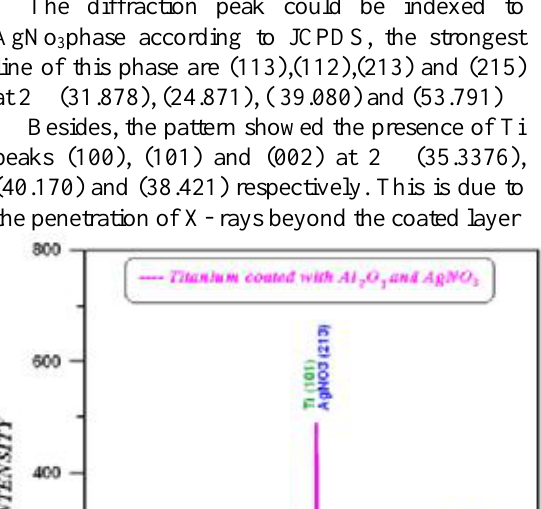
Figure1: X-Ray Diffraction Patterns of CpTi Specimen Coated with Al